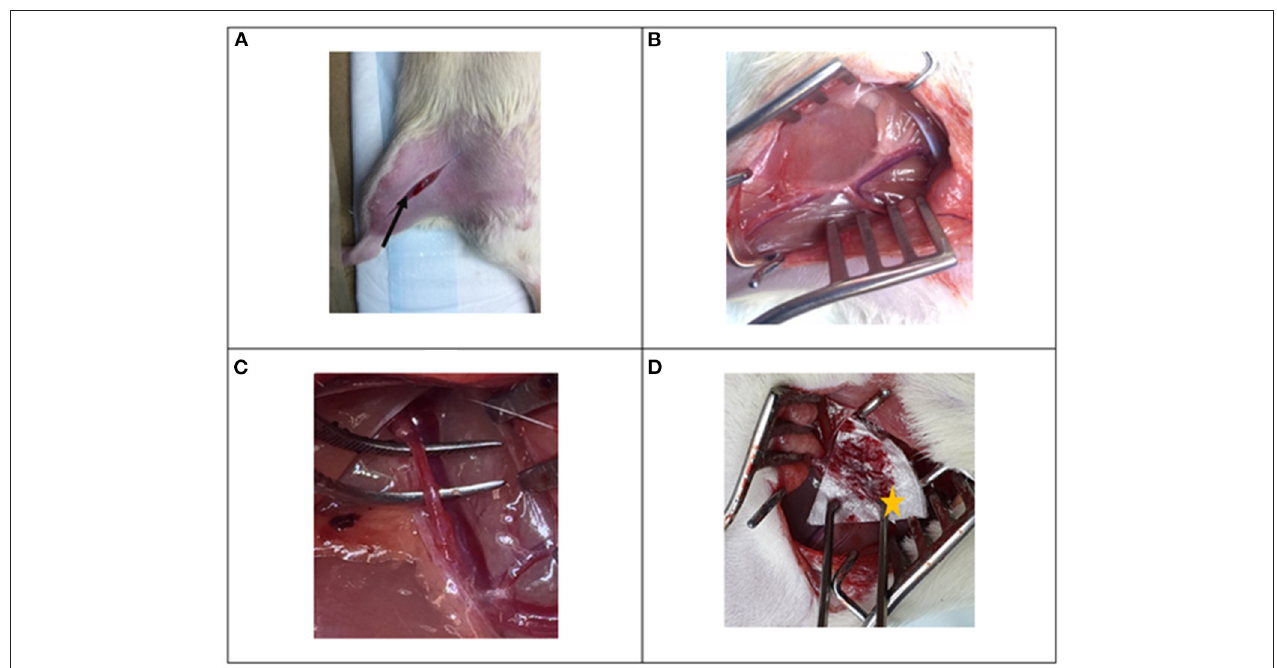
FIGURE 2 | Photographs of surgical procedure for the rat femoral arterial injury experiment. (A) Inguinal incision is made perpendicular to the inguinal canal (black arrow), (B) the femoral bundle is identified and exposed and (C) the proximal femoral artery is dissected away from the femoral vein and femoral nerve. (D) An injury is made to the vessel and the beta-chitin patch (star) is applied to the injury.